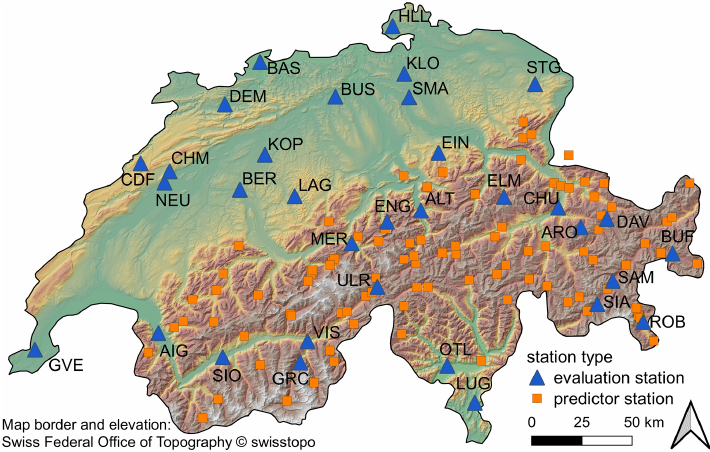
Figure 1. Location of evaluation stations (blue triangles) and predictor stations (orange squares) for the cross-validation study. The back- ground color indicates